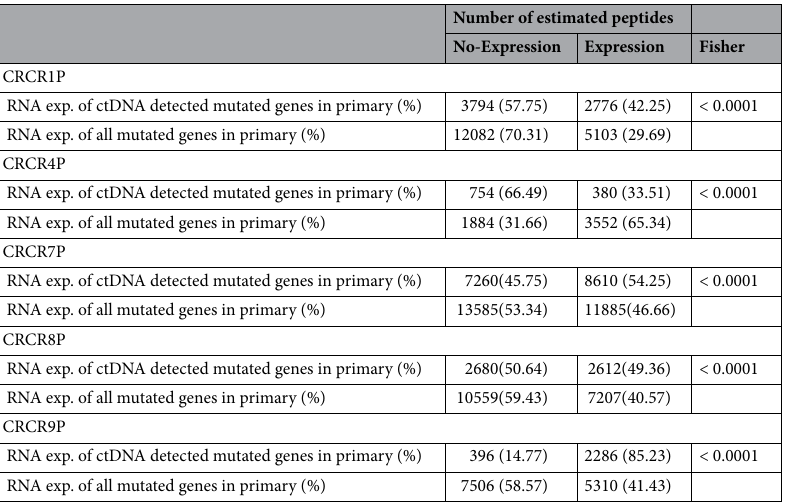
Table 3. Comparison of RNA expression of tumor specific mutated transcripts between ctDNA detected mutated genes and all mutated genes in primary tumor.